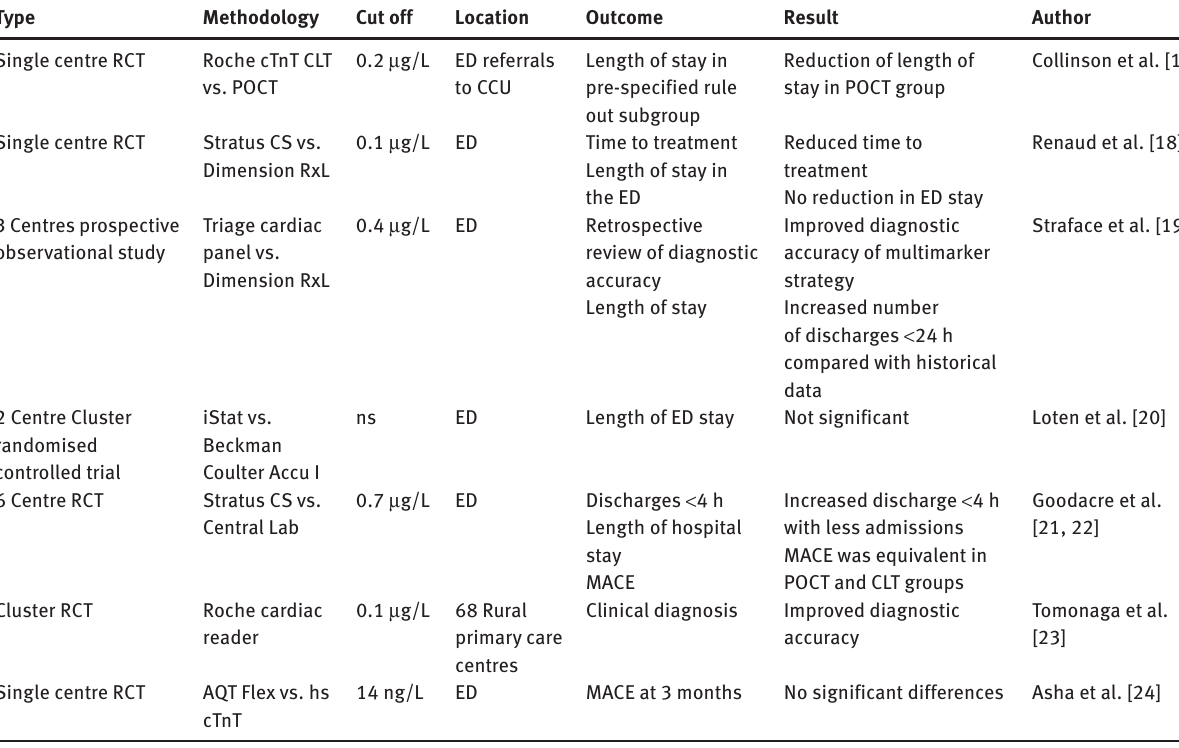
Table 1: Clinical trials of point-of-care